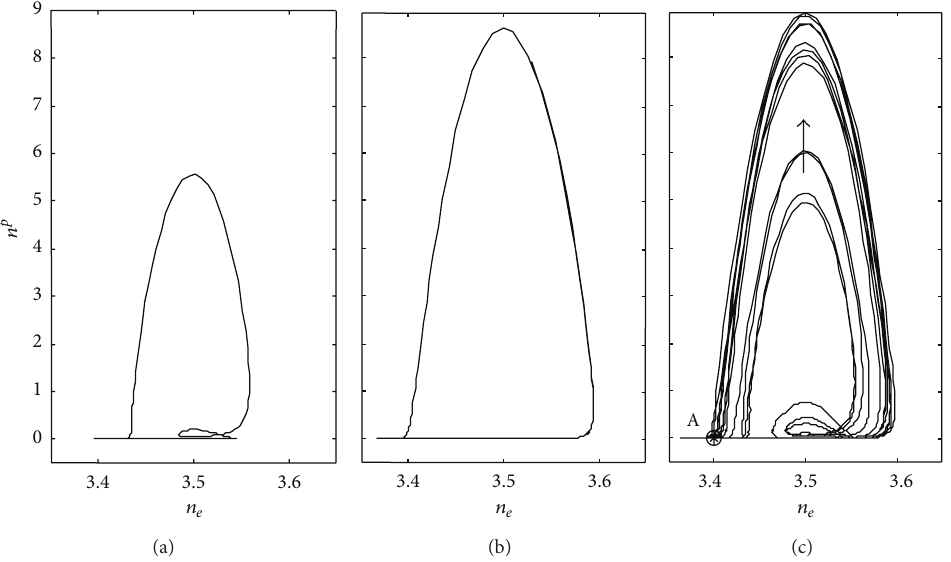
Figure 2: Gaussian noise influence on the system evolution in the phase plane.